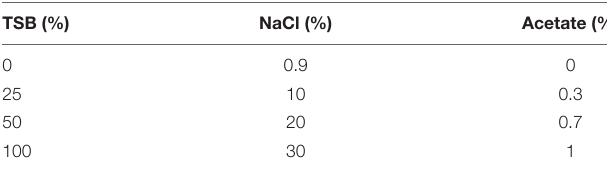
TABLE 3 | External environmental factors during induction of the VBNC state of Salmonella.